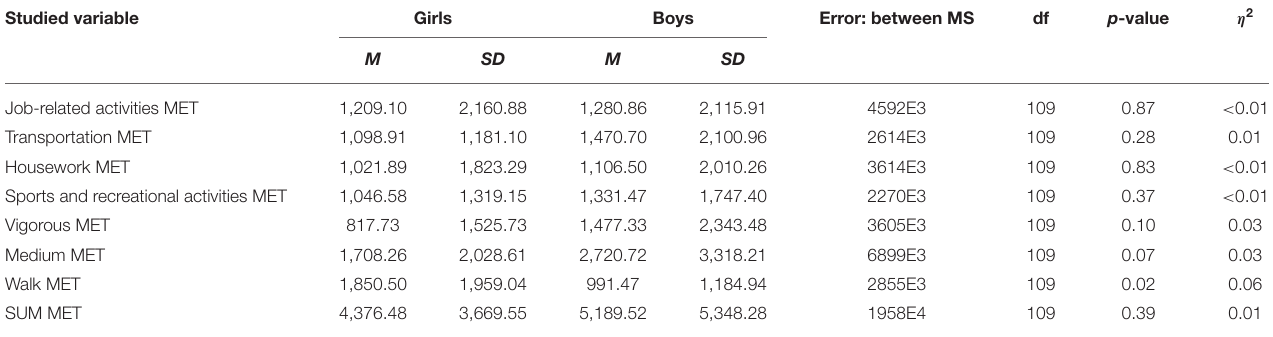
TABLE 3 | Analyses of differences in the IPAQ-LF’s results between girls and boys. Studied variable Girls Boys Error: between MS df p -value η 2 M SD